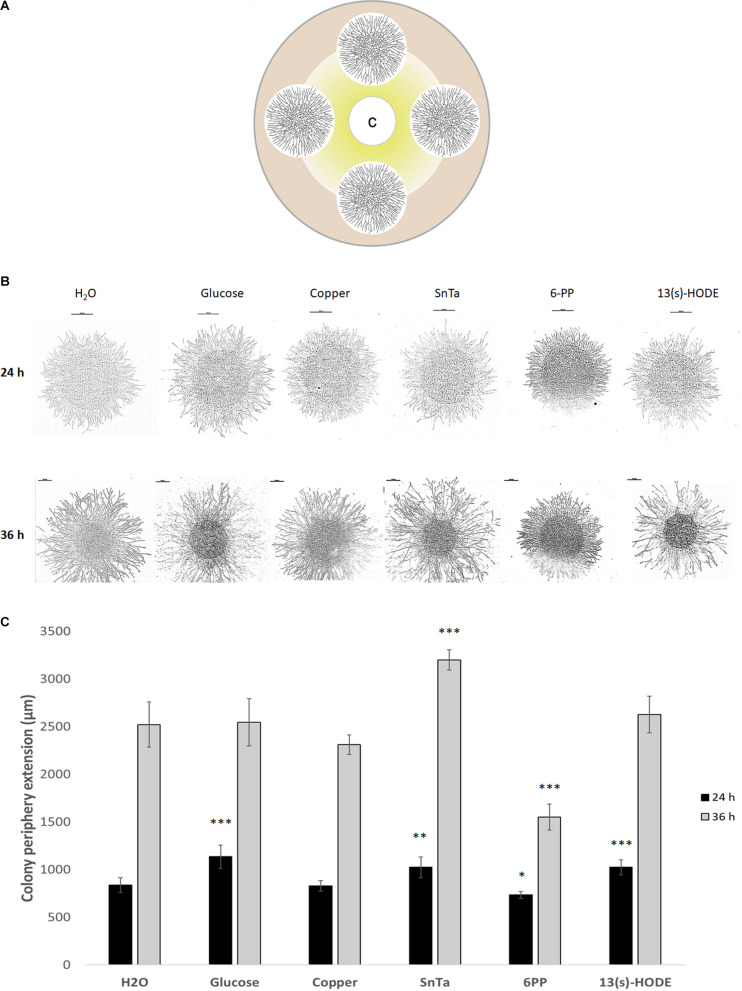
Microcolonies of T. atroviride respond differentially to chemoattractive and chemorepellent compounds by altering colony extension rate and hyphal density. (A) Schematic representation of the assay design, showing four fungal microcolonies of about 1.2 cm diameter arranged equidistant to each other and the central filter disc containing the test compound C. From the filter disc, radial diffusion creates a compound gradient indicated in yellow. (B) Tiled composite microscopic images of microcolonies that developed distinct morphologies with respect to colony extension rate and hyphal density after 24 h and 36 h exposure to the indicated compounds. Scale bars, 1 mm. (C) Quantification of average colony extension rates of microcolonies exemplified in panel (B). Left bars after 24 h compound exposure, right bars after 36 h. SnTa stands out as the most effective modifying compound, however, 6PP and 13(s)-HODE also show significant effects; ∗p ≤ 0.05, ∗∗p ≤ 0.01, ∗∗∗p ≤ 0.001.